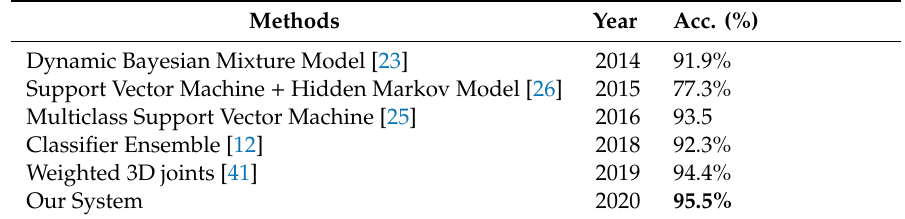
Table 4. Average recognition accuracies (%) of our approach and comparison with previous works using the CAD-60 dataset. The best accuracy level is presented in